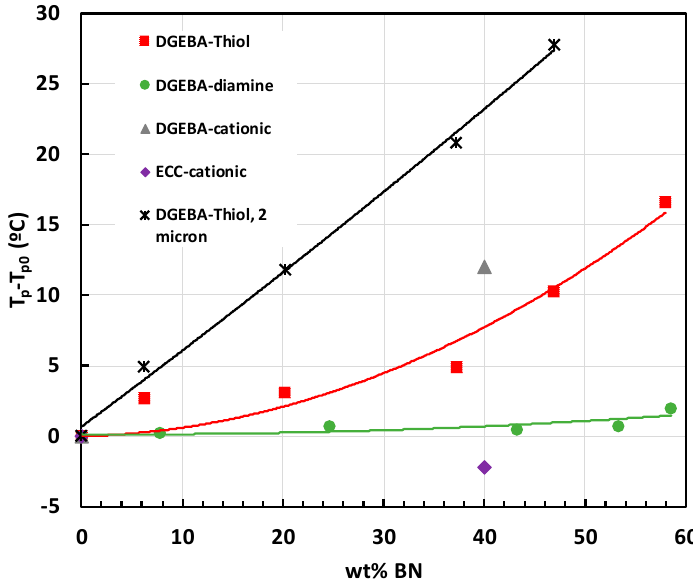
Figure 5. Dependence of peak temperature, T p , on filler content relative to unfilled epoxy, T p0 , for epoxy-BN composites in non-isothermal cure at 10 K / min. 30 µ m platelets: red squares, DGEBA-thiol [65]; grey triangle, DGEBA-cationic [62]; purple diamond, ECC-cationic [62]; green circles, DGEBA-diamine [65]. 2 µ m platelets: black asterisks, DGEBA-thiol [65].